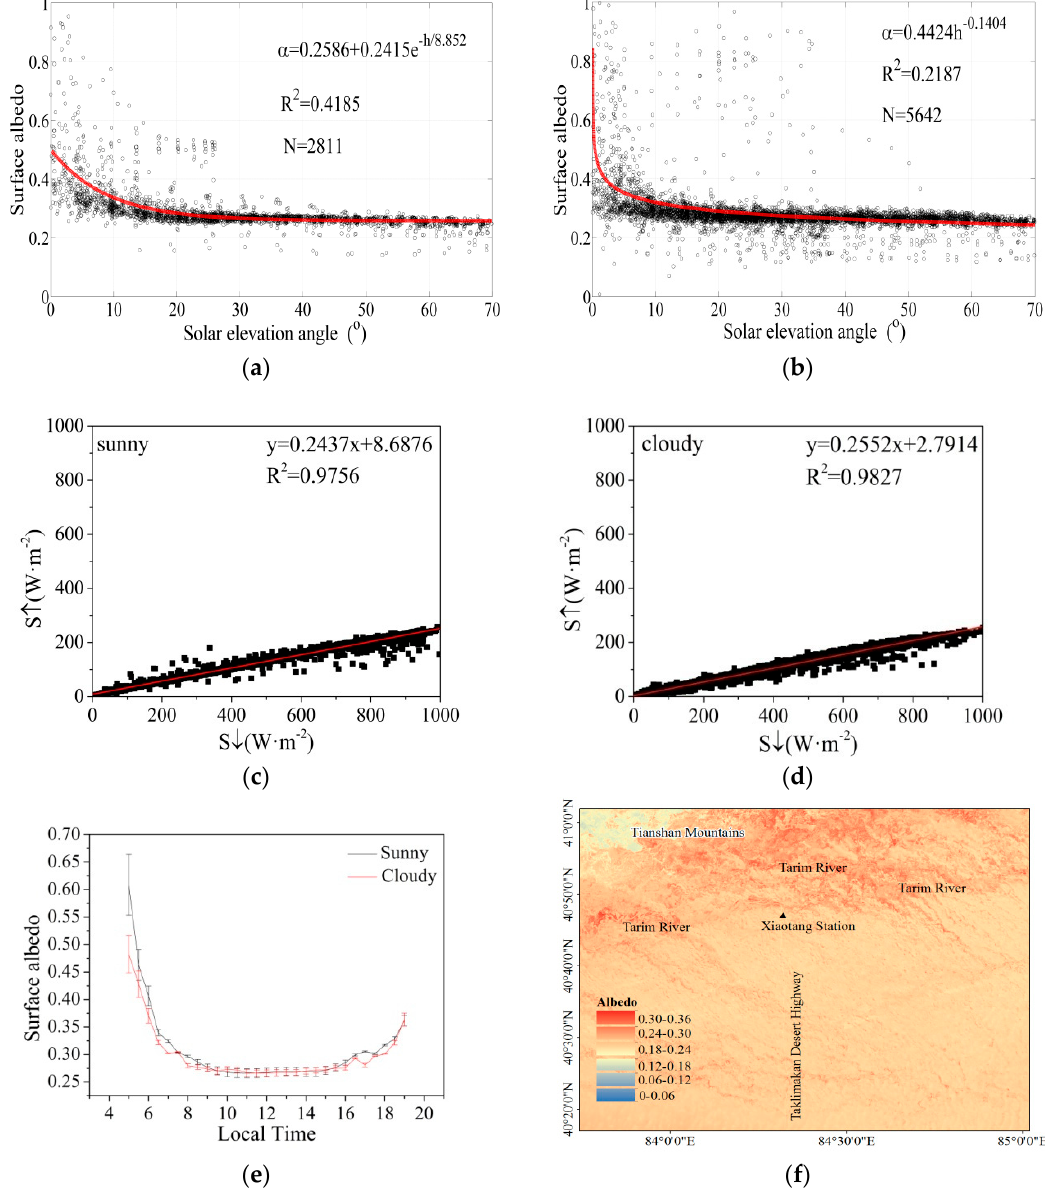
Figure 4. ( a ) Changes in the surface albedo with solar elevation angles on sunny days at Xiaotang station during 5 January to 31 December 2010. ( b ) Same as ( a ) but on cloudy days. ( c ) Scatter plot of outgoing against incoming radiation on sunny days. ( d ) Same as ( c ) but on cloudy days. ( e ) Diurnal variations in the surface albedo on sunny days and cloudy days. ( f ) Retrieval of the surface albedo from Landsat